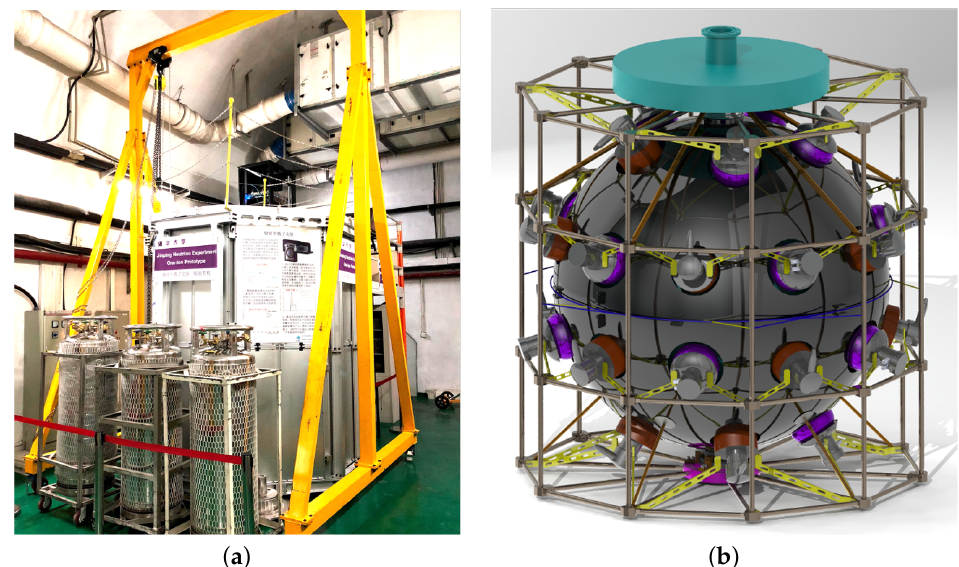
Figure 3. Views of the one-ton spherical liquid scintillator detector: ( a ) external structure and ( b ) internal